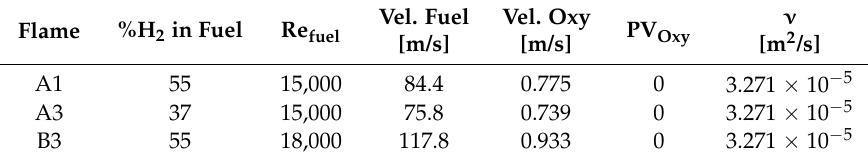
Table 2. Description of the initial/boundary numerical conditions for Oxyfuel Flames. Flame